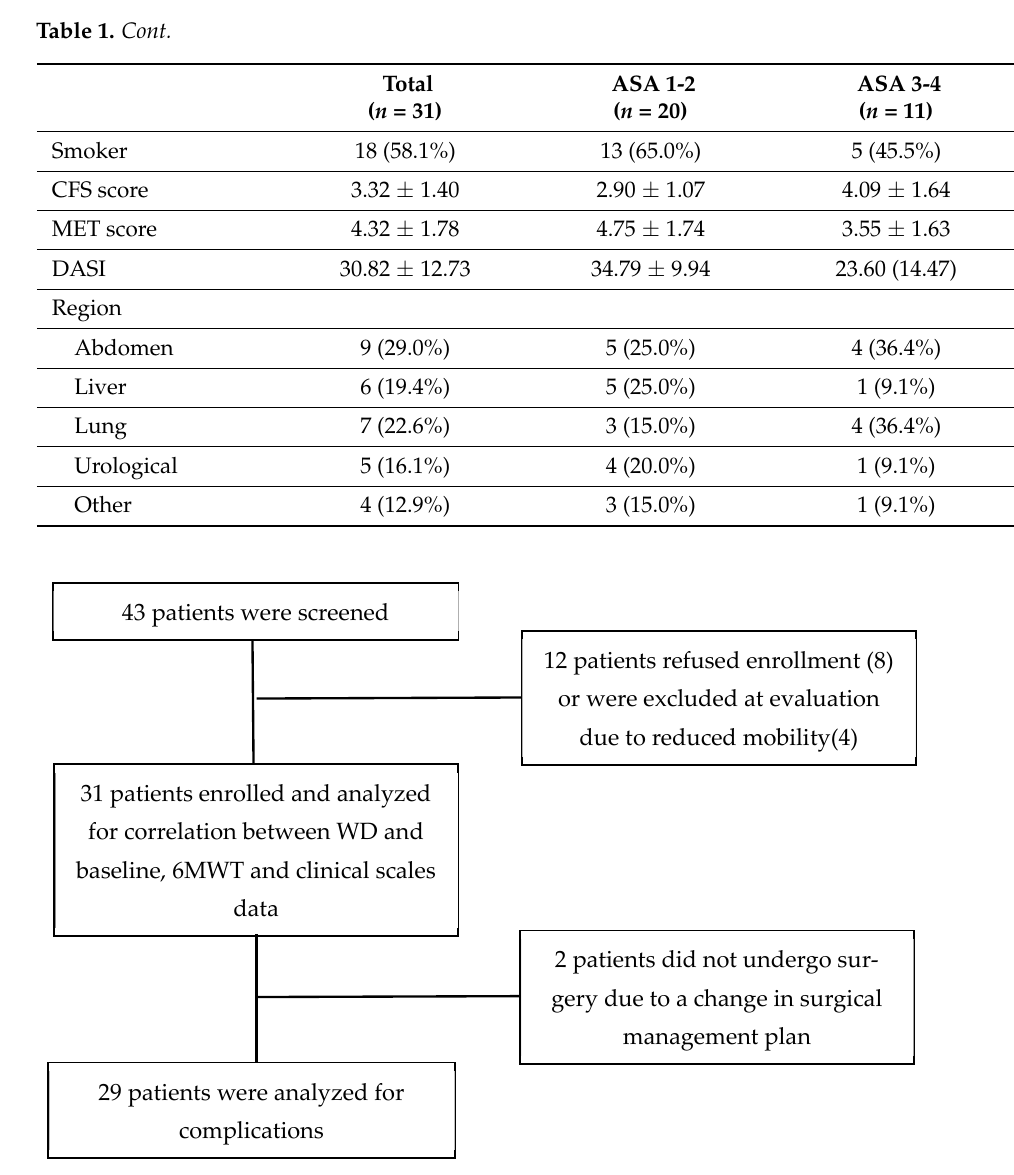
Figure 1. Flowchart of study process.